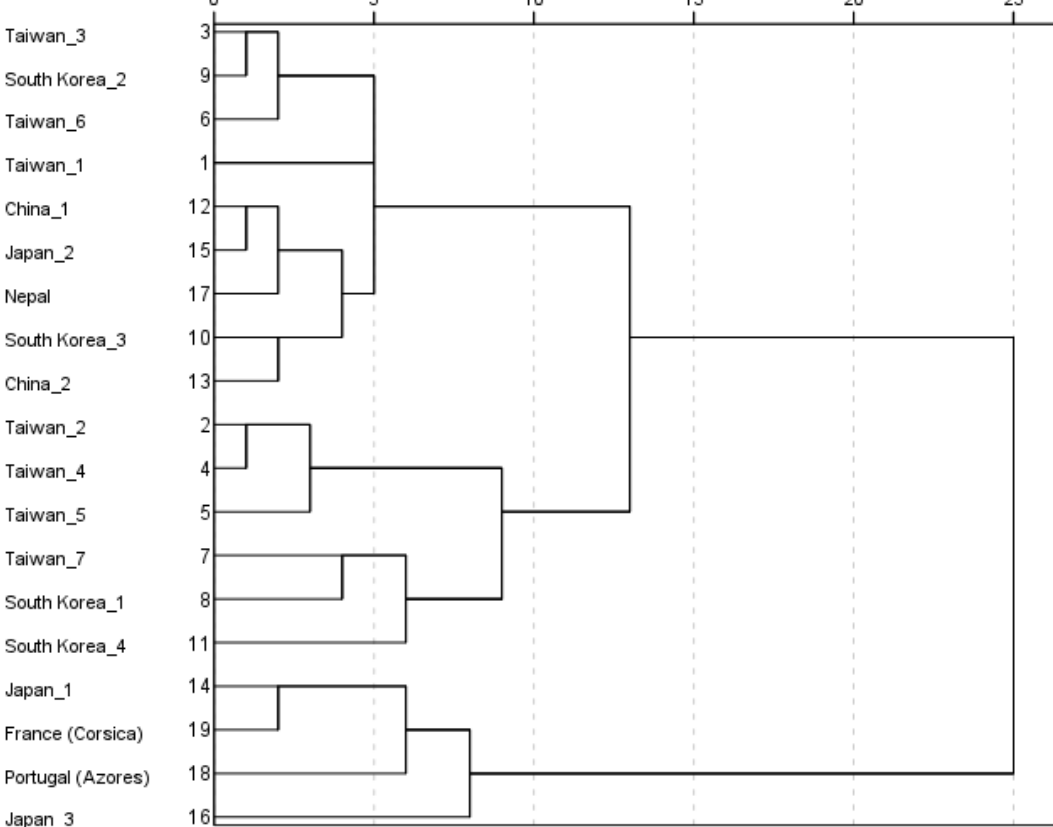
Figure 3. Hierarchical cluster analysis dendrogram results of 19 Cryptomeria japonica essential oil samples, obtained by Euclidean distance and Ward Linkage method.